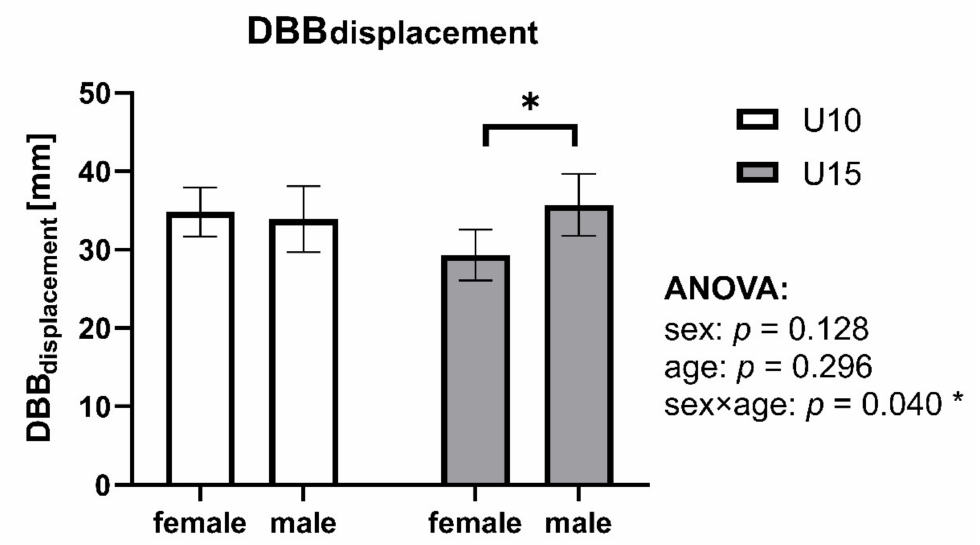
Figure 2. DBB displacement separated by age and sex. Data are expressed as the mean ± 95% CI. Level of significance based on a two-way ANOVA: * sign ( p <